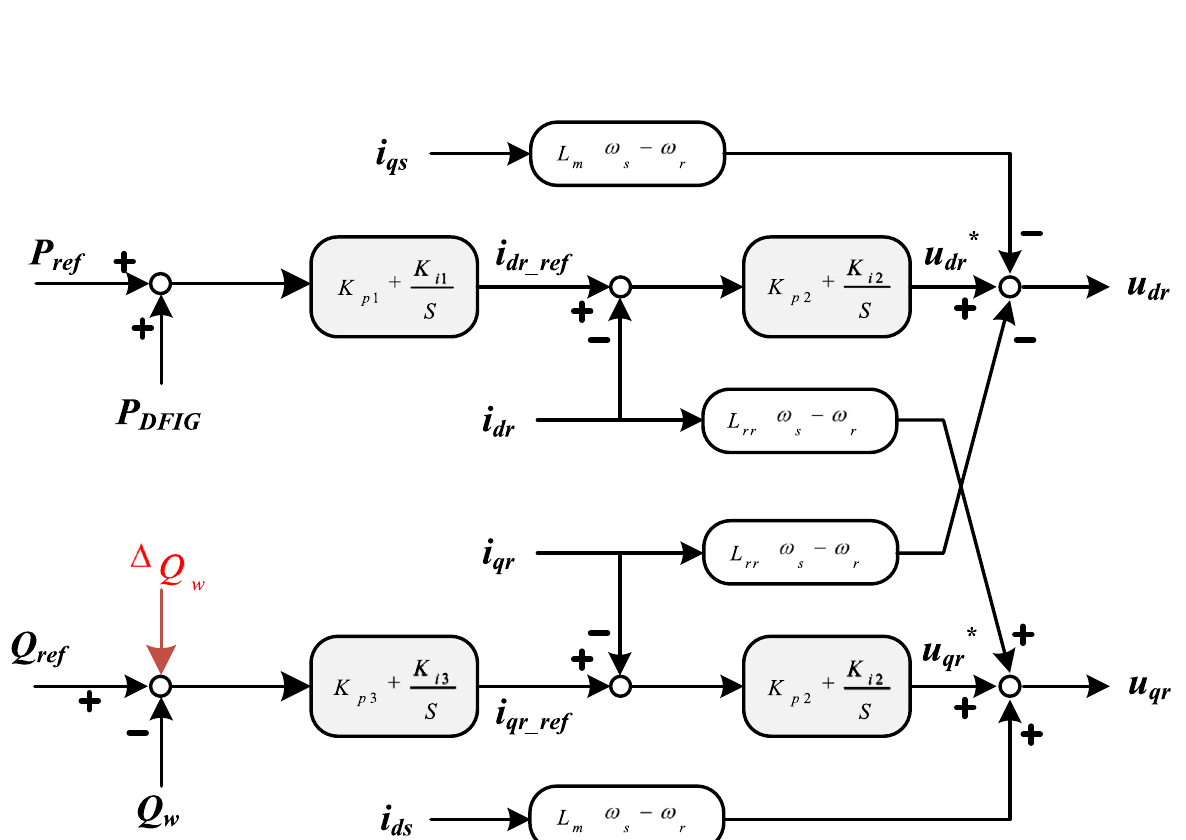
Fig. 3 Block diagram of the RSC